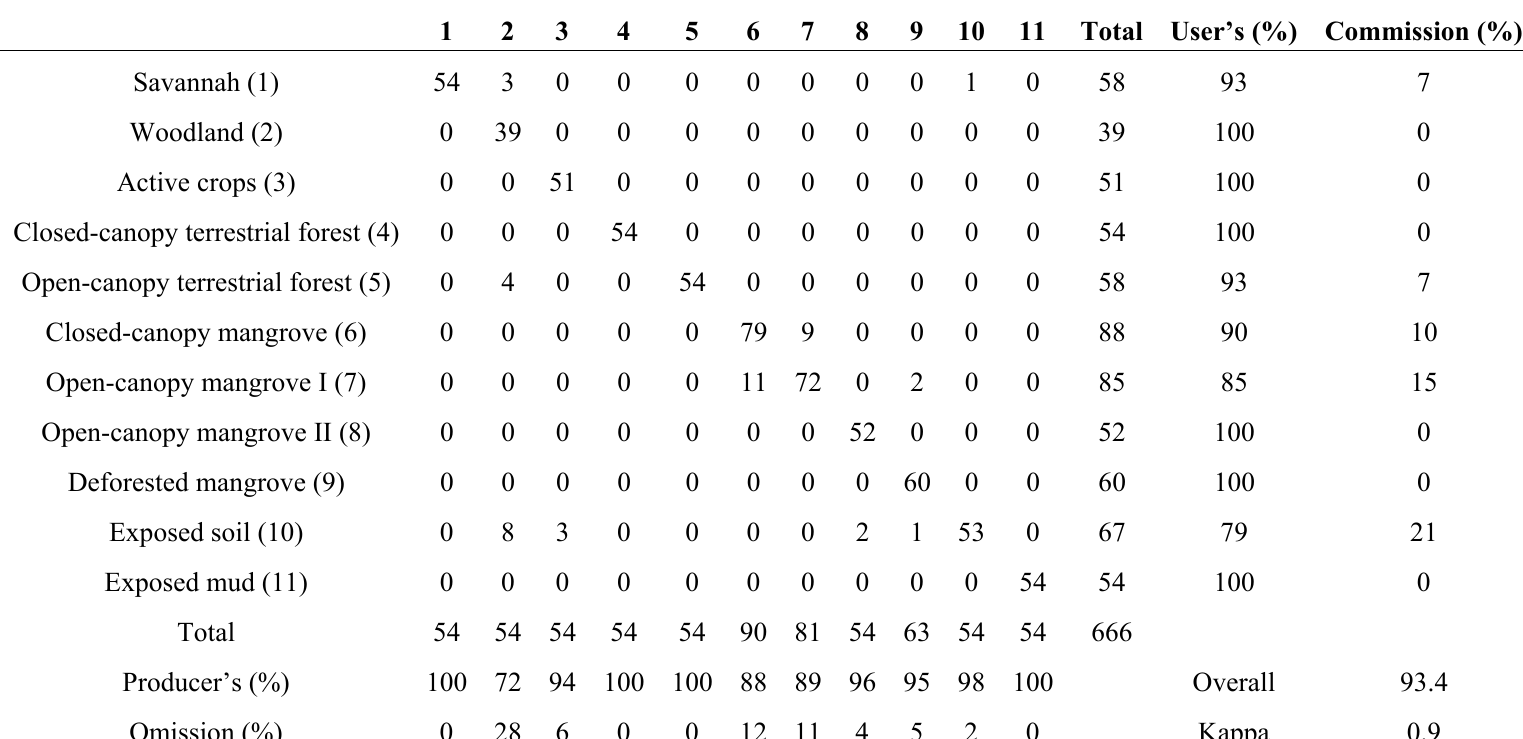
Table 3. Confusion matrix for maximum likelihood classification of GLS 2010 Landsat